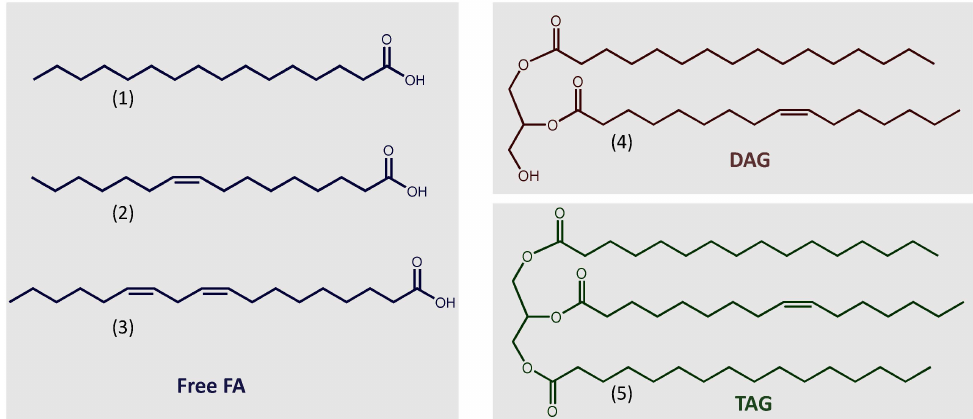
Figure 1. Chemical structures of commonly representative lipids. ( 1 ) Palmitic acid (16:0); ( 2 ) Palmi- toleic acid (16:1); ( 3 ) Linoleic acid (18:2); ( 4 ) DAG (16:0/16:1); ( 5 ) TAG (16:0/16:1/16:0). Abbreviations: DAG, diacylglycerol; FA, fatty acid; TAG,